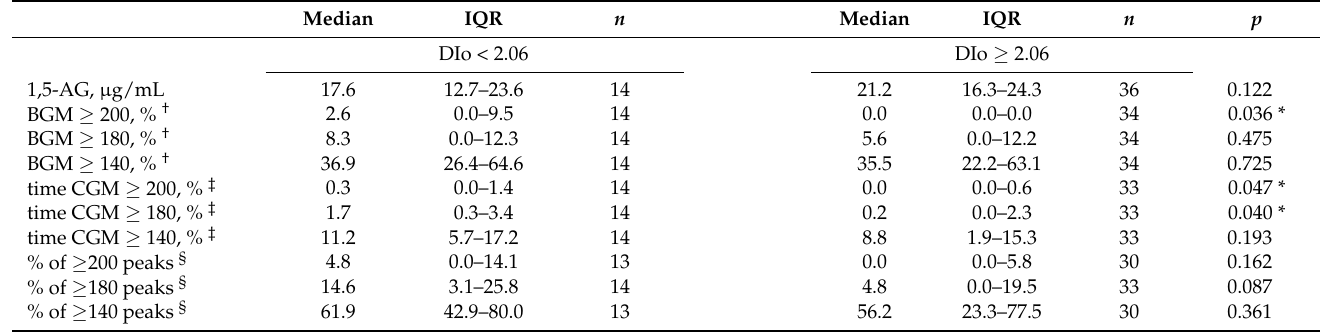
Table 5. The median and interquartile range of indices for postprandial hyperglycemia stratified with DIo